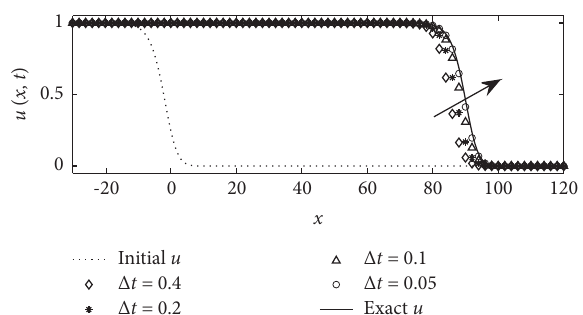
Figure 4: Schematic diagram of the interpolation.